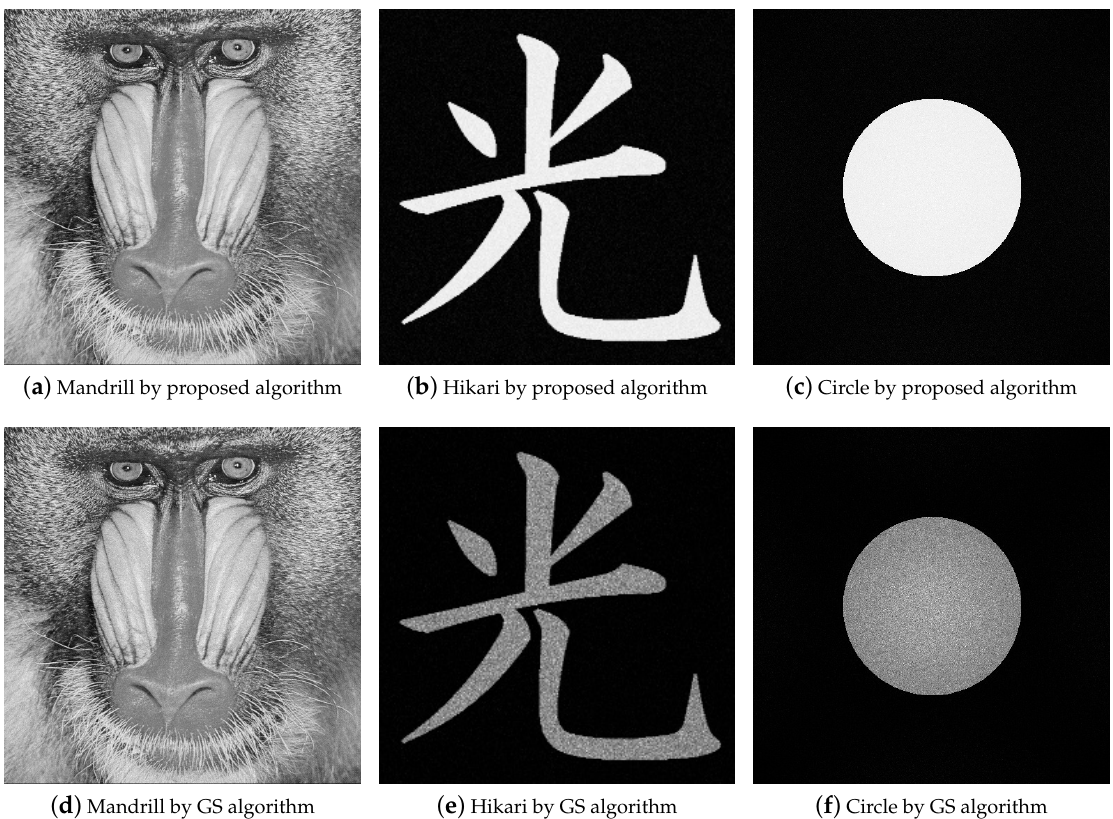
Figure 6. Reconstructed images obtained with ( a – c ) the proposed technique and ( d – f ) the GS algorithm;